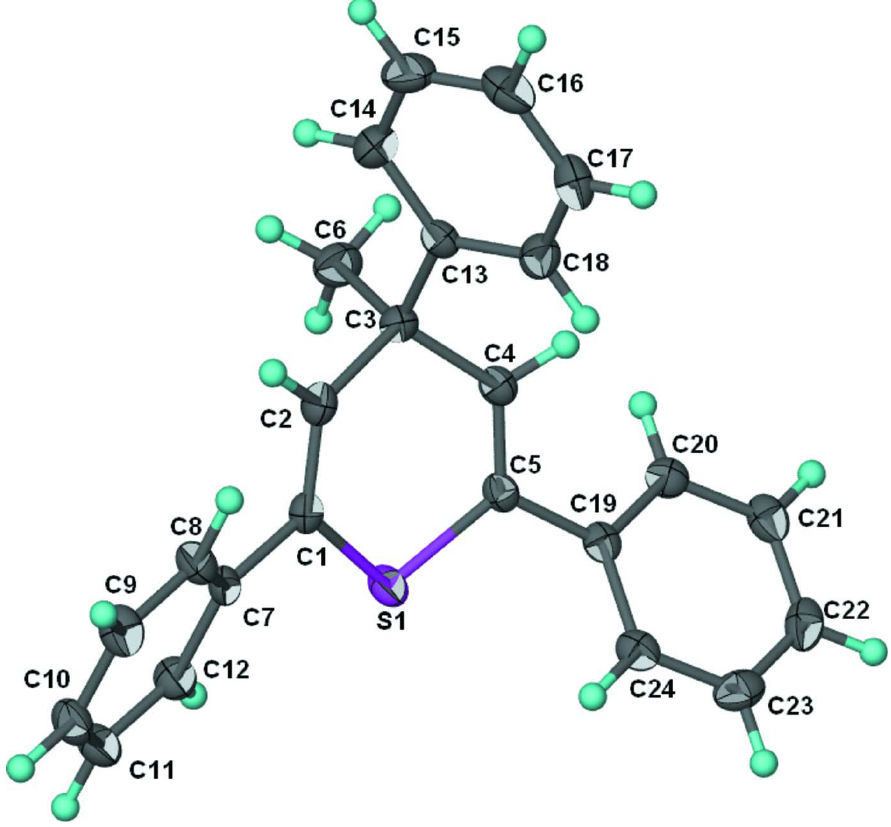
Figure 1 Thermal ellisoid plot (Barbour, 2001) of C arbitrary